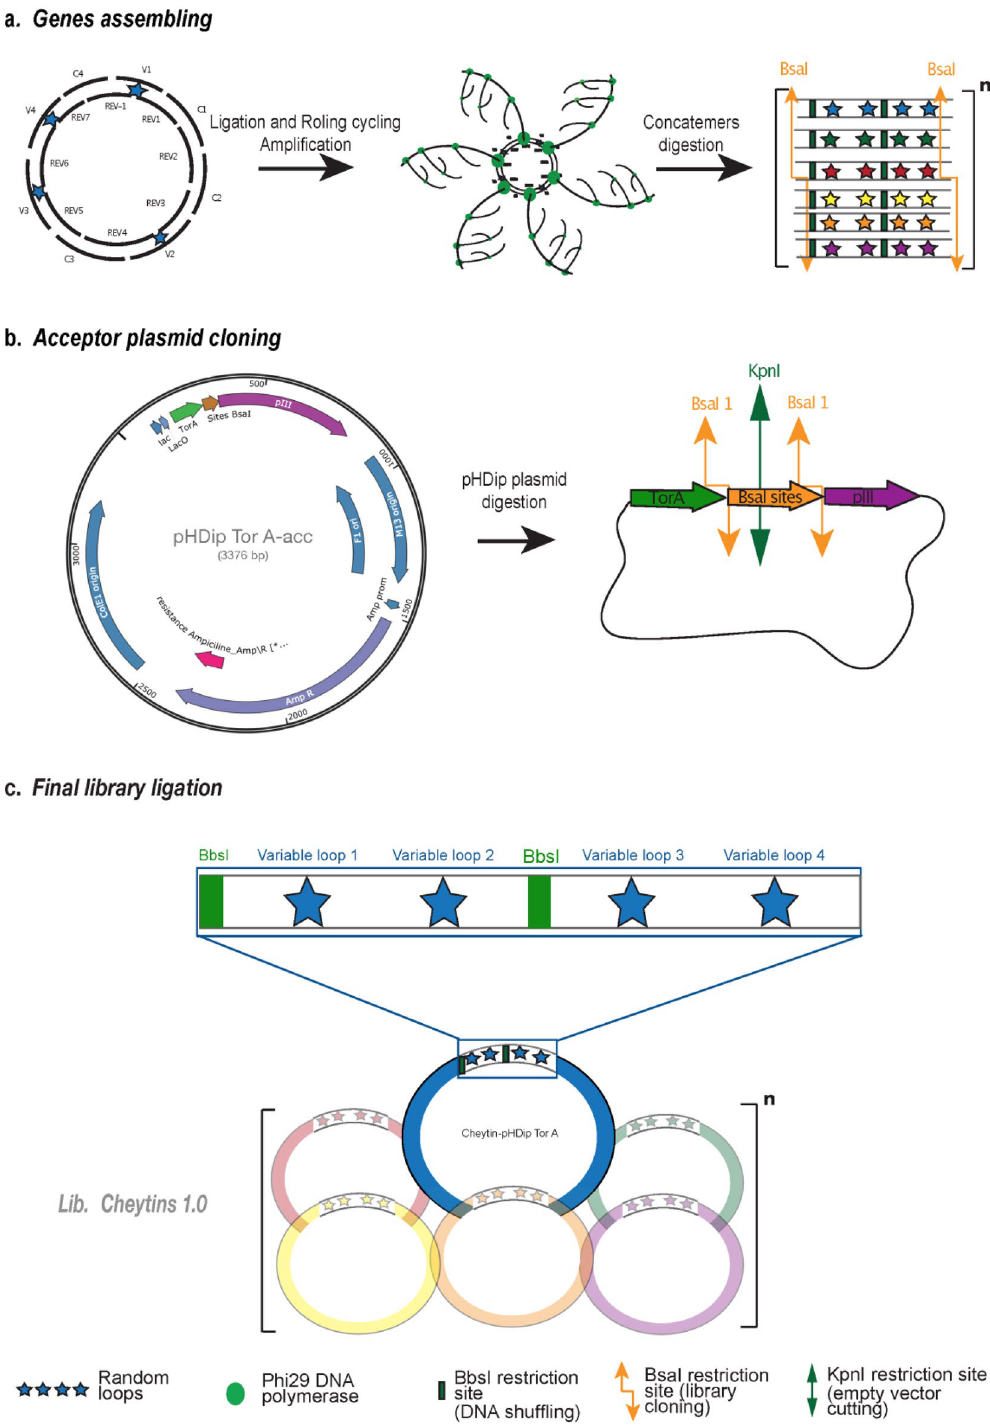
Figure 2. Cheytins-library construction. ( a ) The sequence corresponding to the CheytinWT protein was coded by a set of oligonucleotides including four variable degenerate oligonucleotides (V1–V4); four constant, non-degenerate oligonucleotides (C1– C4); degeneration is indicated by stars and corresponds to amino acid positions 10, 11, 12, 57, 58, 59, 60, 84, 85, 86, 105, and 107 in the sequence of the CheytinWT. (Detailed oligonucleotide sequences are given in Materials and Methods). The oligonucleotides were assembled with eight reverse primers (Rev1–Rev7 + Rev-1) and ligated to form DNA circles coding for the Cheytin sequence. The circles were used as a matrix for RCA amplification to generate double-stranded homopolymers of Cheytin variants. Digestion of the RCA products with a restriction enzyme (BsaI) gave rise to a collection of single Cheytin variants with different sequences. ( b ) A detailed view of the acceptor vector pHDip TorA. The acceptor vector (pHDip Tor A -acc) used for the library construction contains a cassette with two BsaI restriction sites. BsaI digestion of this vector generates compatibles ends with the insert encoding Cheytin variants obtained after RCA product digestion with BsaI. Each phagemide of the library is circularized by ligation. ( c ) Final assembly of the library: The sequences of the Cheytin variants were ligated in acceptor vector (pHDip Tor A- acc) previously digested at KpnI and BsaI restriction sites. The KpnI site was used to prevent recircularization of the acceptor vector throughout